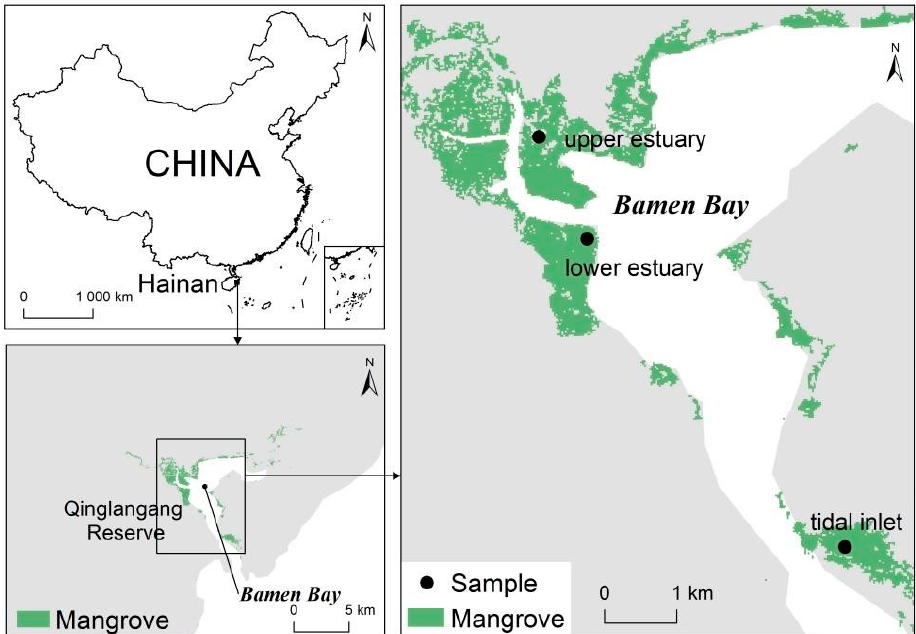
Figure 1. Location of sample plots (black circles) in Qinglan harbor mangrove forest, Hainan province.